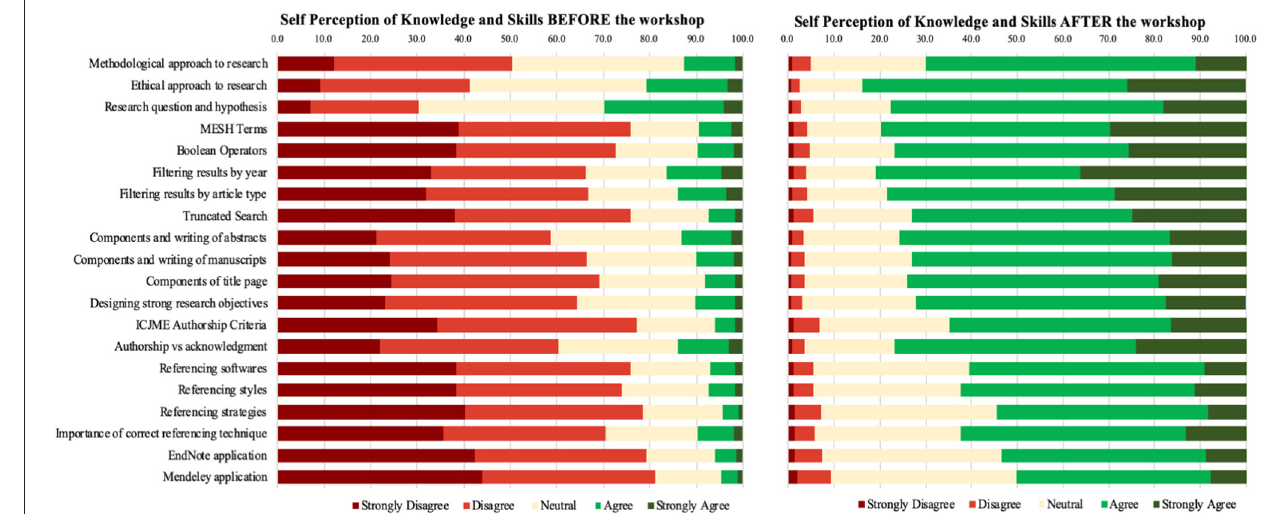
FIGURE 3 | Subjective assessment: categorical assortment of participants’